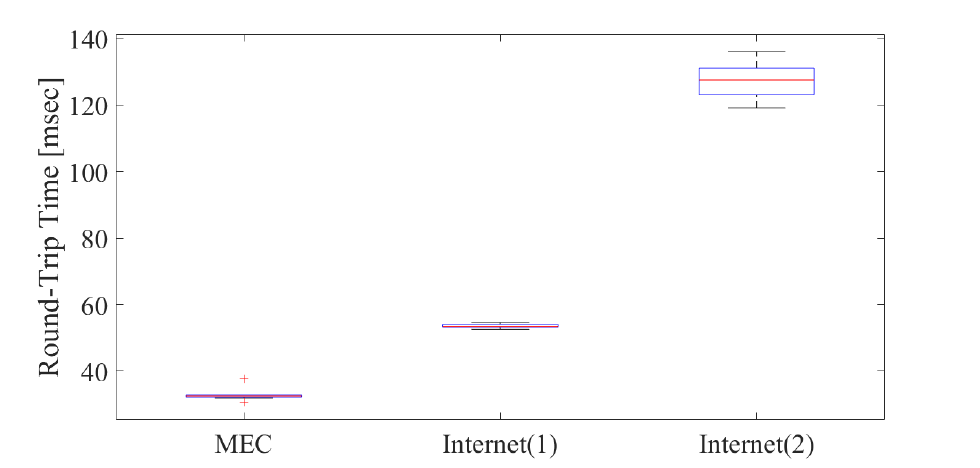
Figure 12. Latency comparison of MEC and